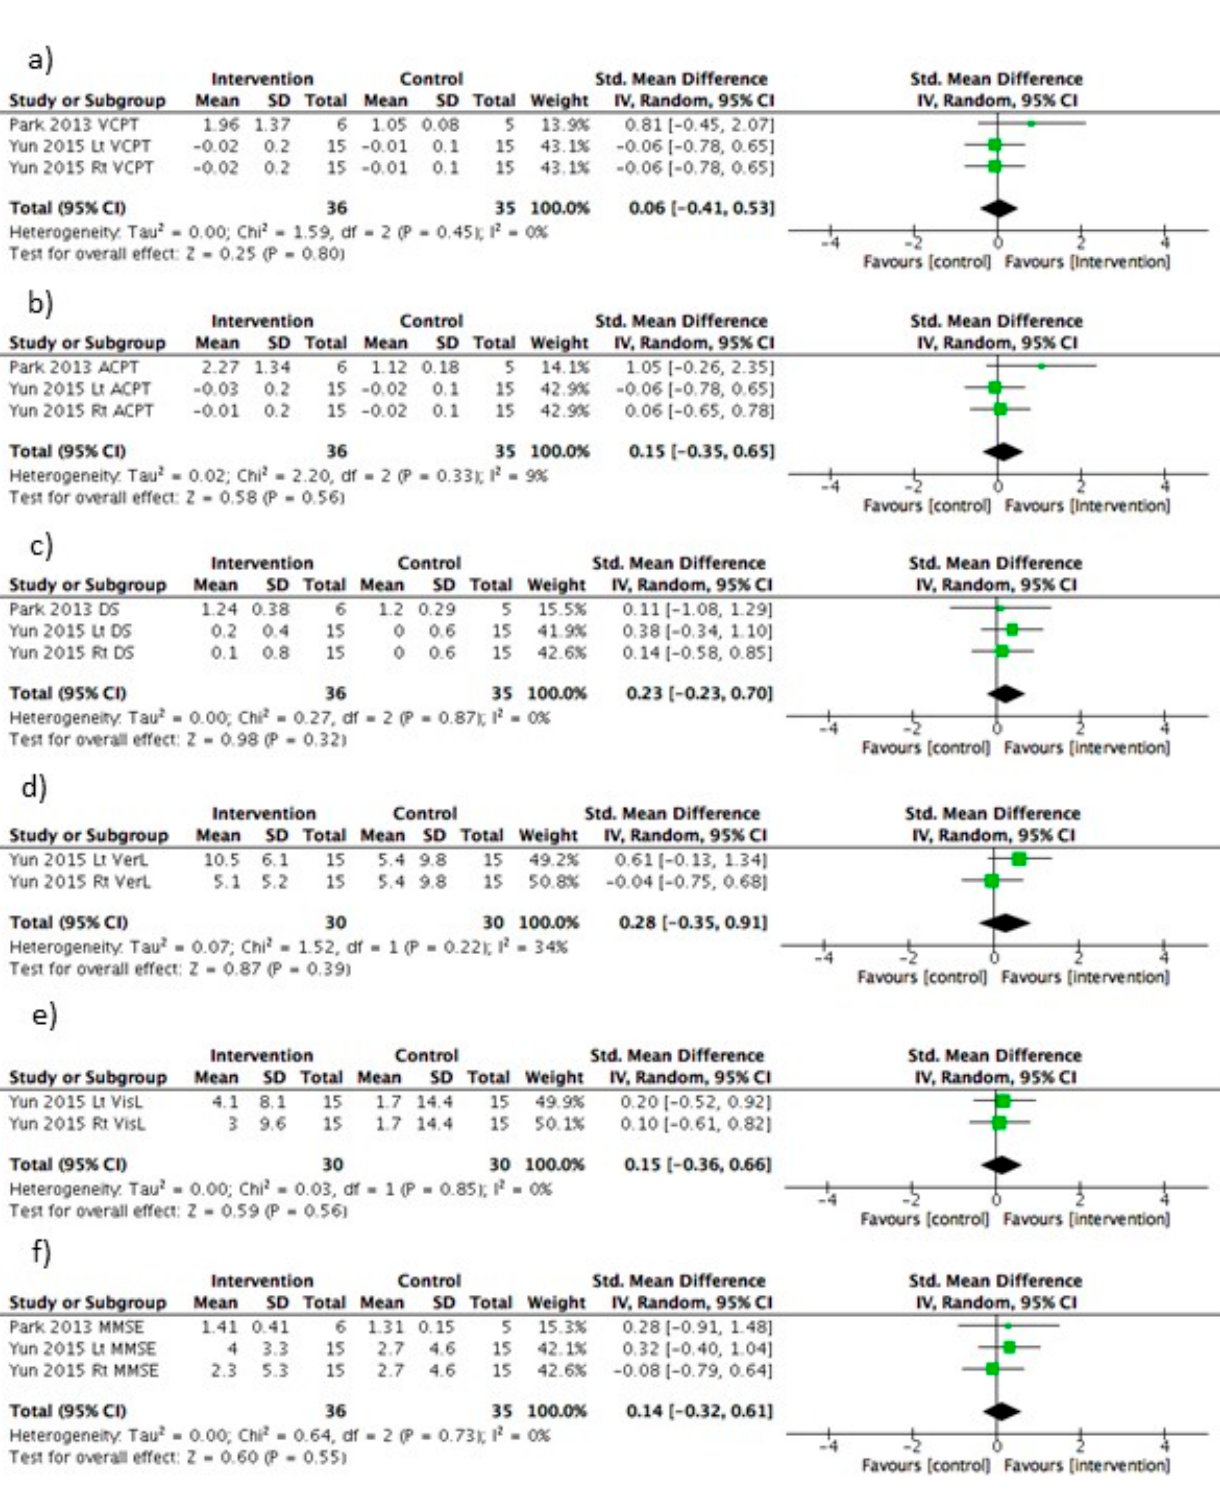
Figure 4. Forest plot of tDCS with neuropsychological tests outcome. ( a ) Attention in visual continuous performance test(VCPT), ( b ) Attention in auditory continuous performance test(ACPT), ( c ) Working Memory, ( d ) Memory in verbal learning test(VerL) ( e ) Memory in visual learning test(VisL), ( f ) Cognition, Catherine Bergego Scale; CI, confidence interval; SD, standard deviation ; Std, standard.